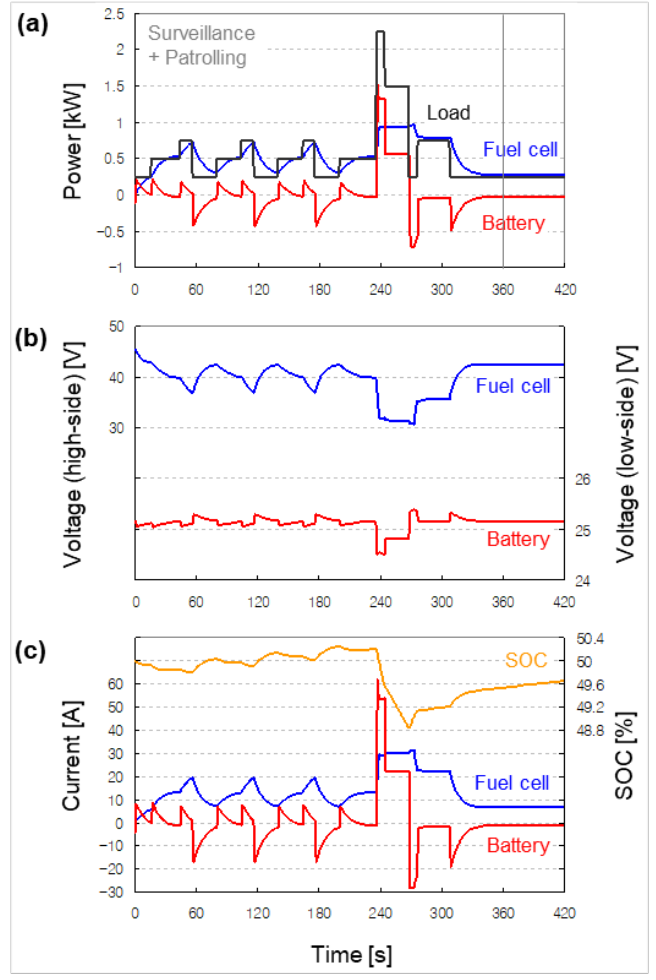
Figure 13. Simulated ( a ) power, ( b ) voltage, and ( c ) current with SOC of HPS throughout a half cycle (until 360 s).